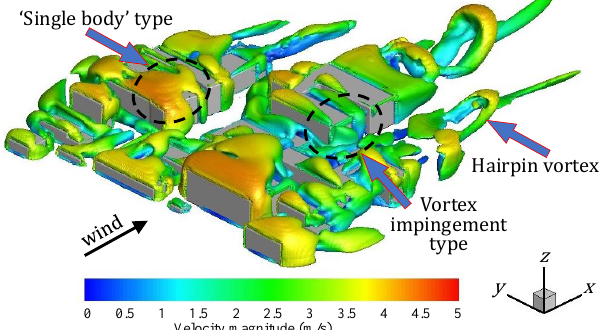
Figure 5. Perspective view of instantaneous iso-surface of the Q -criterion ( Q = 0.001) colored by iso-contours of the streamwise